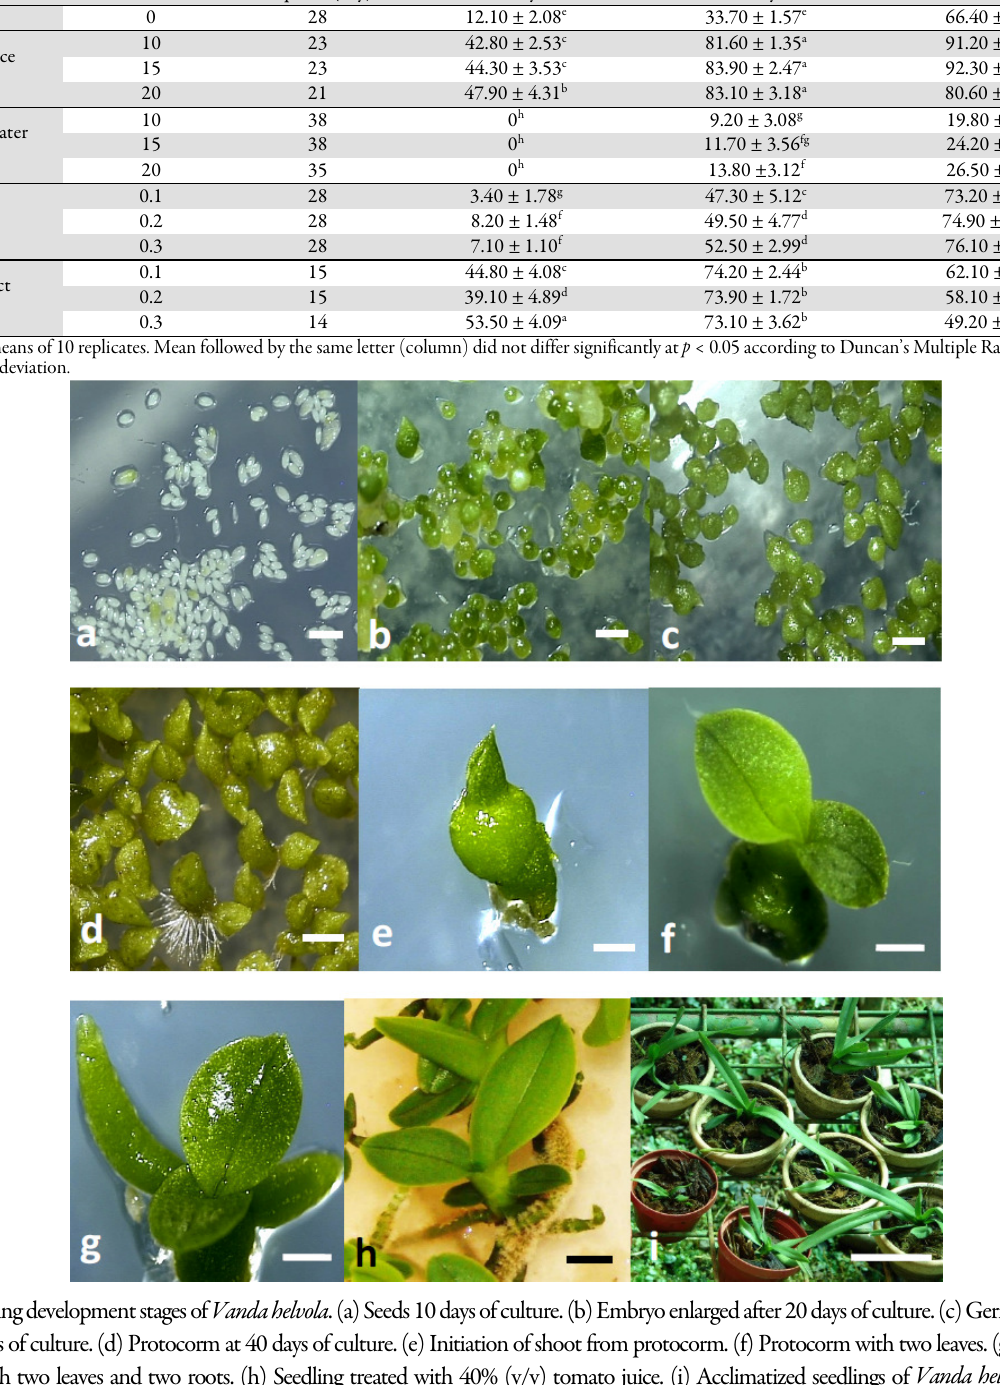
Table 2. Effect of organic additives on Vanda helvola seeds germination, cultured on KC basal medium Organic additive